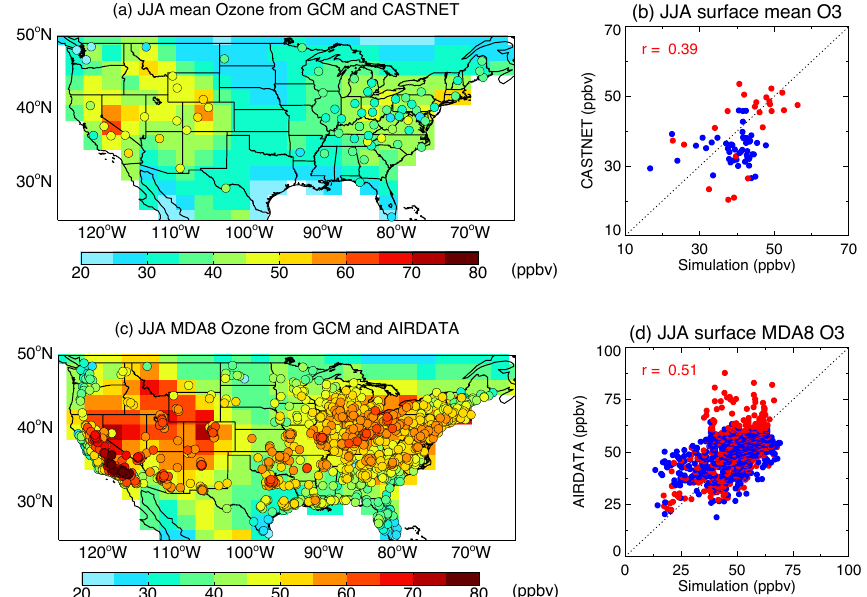
Figure 4. Validation of simulated June–July–August (JJA) summertime average surface (a, b) diurnal mean and (c, d) daily maximum 8h average O 3 with in situ measurements from (a, b) the EPA Clean Air Status and Trends Network (CASTNET) and (c, d) the AIRDATA. For (b) and (d) , the blue points indicate sites east of 95 ◦ W and the red points indicate sites west of 95 ◦ W. The correlation coefficients are shown in (b) and (d) . Each point in (b) and (d) represents the mean value for JJA at one specific site. Results for the model and observations are separated out in Fig. S7 in the Supplement.